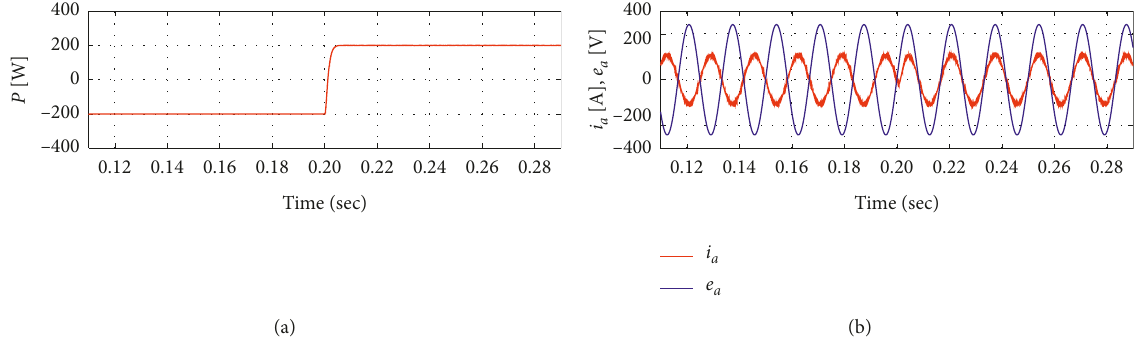
Figure 10: (a) Active power and (b) grid voltage and current during discharging and charging mode.